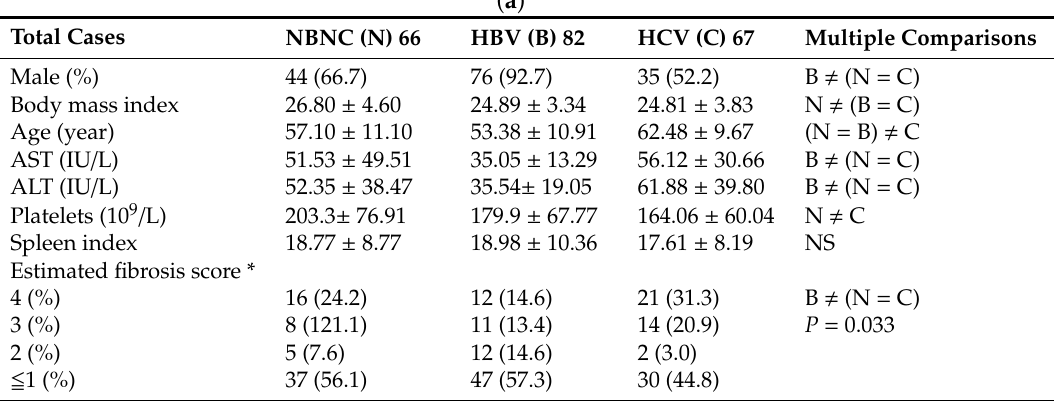
Table 1. ( a ) Demography of patients without liver histology study; ( b ) Demography of patients received Table 1a. Demography of patients without liver histology study. liver histology